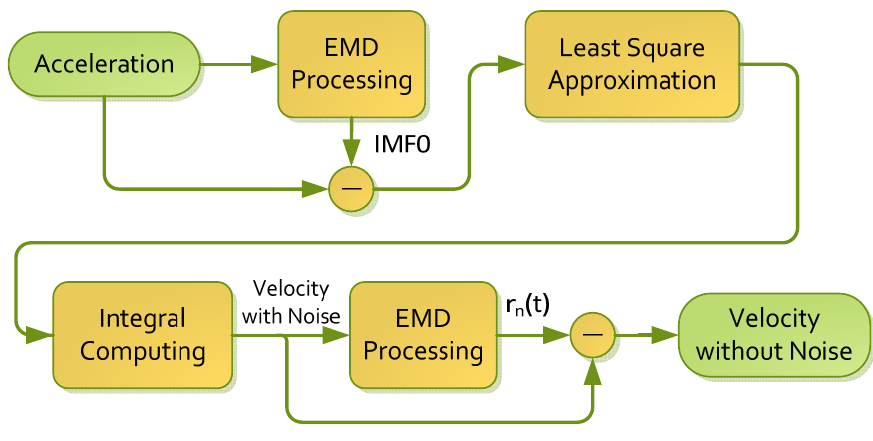
Figure 11. The flowchart of filtering acceleration noise.